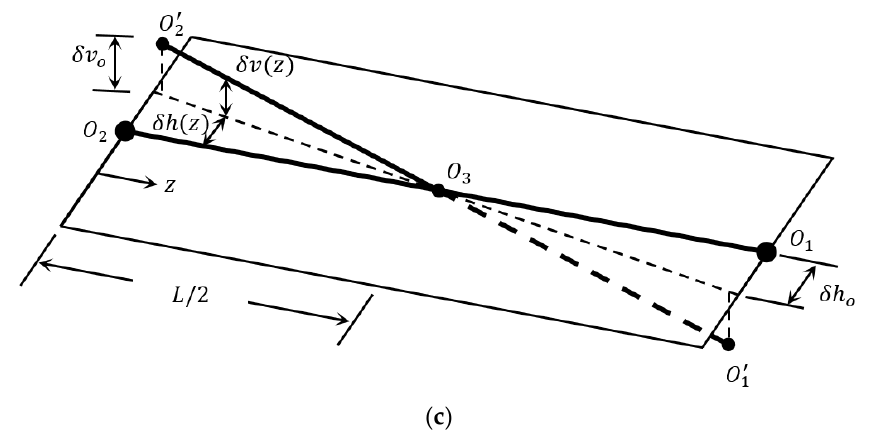
Figure 2. Schematic drawing illustrates: ( a ) side view of aligned bearing, ( b ) 3D aligned bearing, and ( c ) misalignment model [30].